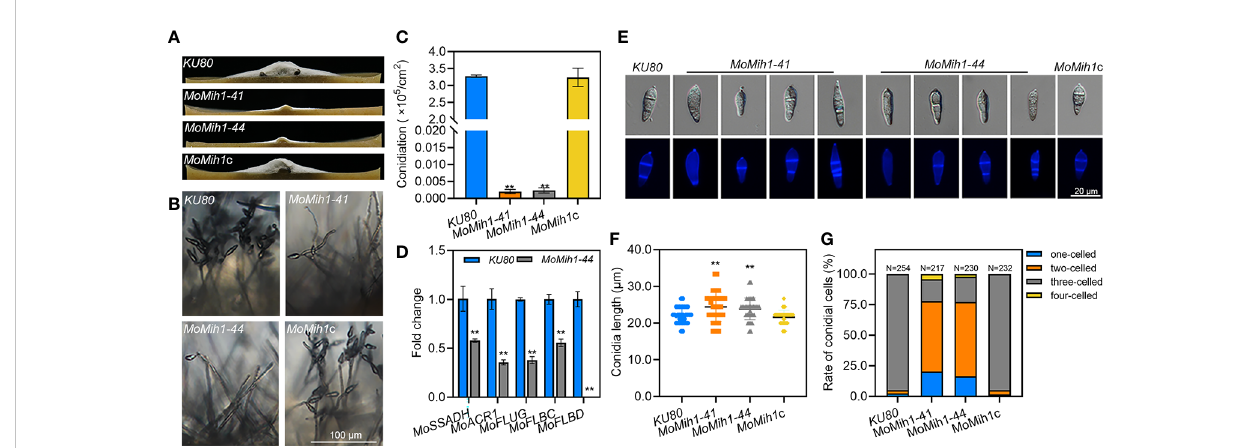
FIGURE 4 MoMih1 is required for the conidiation and conidial morphology of M. oryzae . (A) Comparison of aerial hyphae growth. All strains were grown on RDC media under darkness, and then photographed at 5 dpi. (B) Conidia formation on the conidiophores. Light microscopic observation was carried out to examine the conidia development on the conidiophores of the MoMih1 mutants that grown on RDC at 7dpi. Bar = 100 m m. (C) Statistical analysis of conidia reproduction. The conidia formed by each tested strain were collected and statically analyzed. “ ** ” means signi fi cant difference among the tested strains ( p < 0.01), and error bars indicate SD. (D) Transcription of the conidiation-related genes. The expression of conidiation-related genes was examined by qRT-PCR in the KU80 and MoMih1 mutants. “ ** ” means signi fi cant differences ( p <0.01), and error bars represent SD. (E) Conidial morphology of MoMih1 mutant. Conidia of each tested strain were stained with CFW, and then observed by differential interference contrast (DIC) microscopy and UV fl uorescence microscopy. (F) Statistical analysis of conidial length. The conidial length was determined by measuring more than 200 conidia, and then statistically analyzed. “ ** ” means signi fi cant difference among the strains ( p < 0.01), and error bars represent SD. (G) Ratio of conidia with different number of cells in the MoMih1 mutant. The proportion of conidia with different cell numbers was statistically analyzed from three independent experiments. “ ** ” means signi fi cant difference among the tested strains ( p < 0.01), and error bars represent